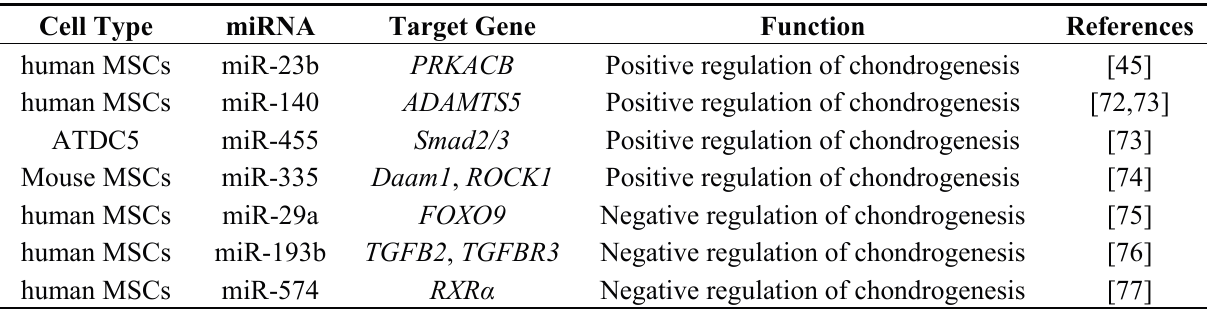
Table 1. Summary of chondrogenic differentiation by